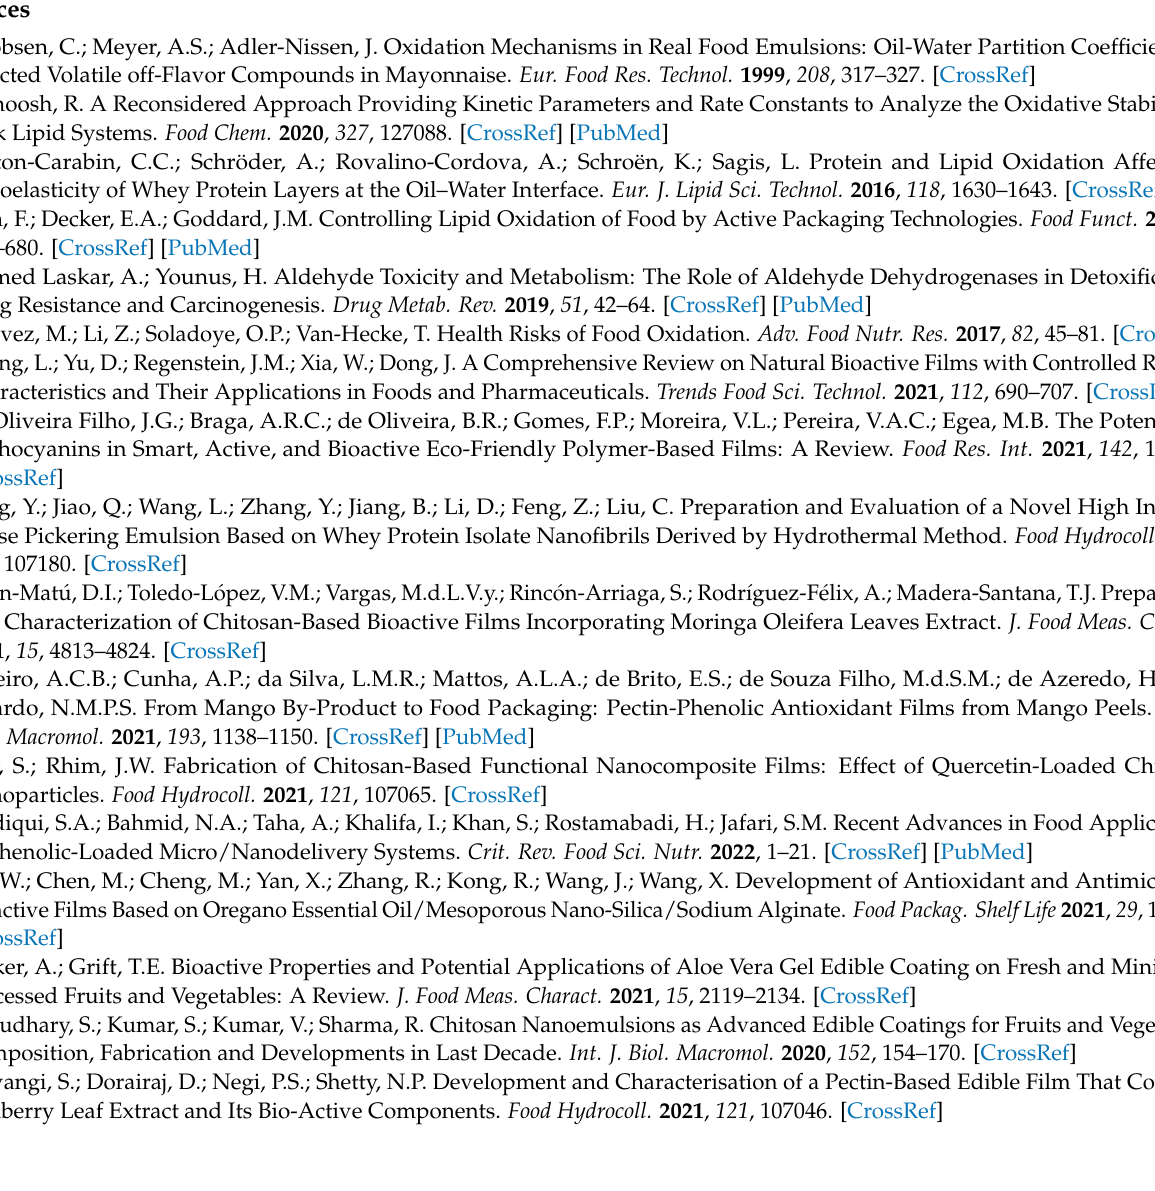
Figure A3. The calibration curve of NAG that was used to calculate the degree of acetylation.